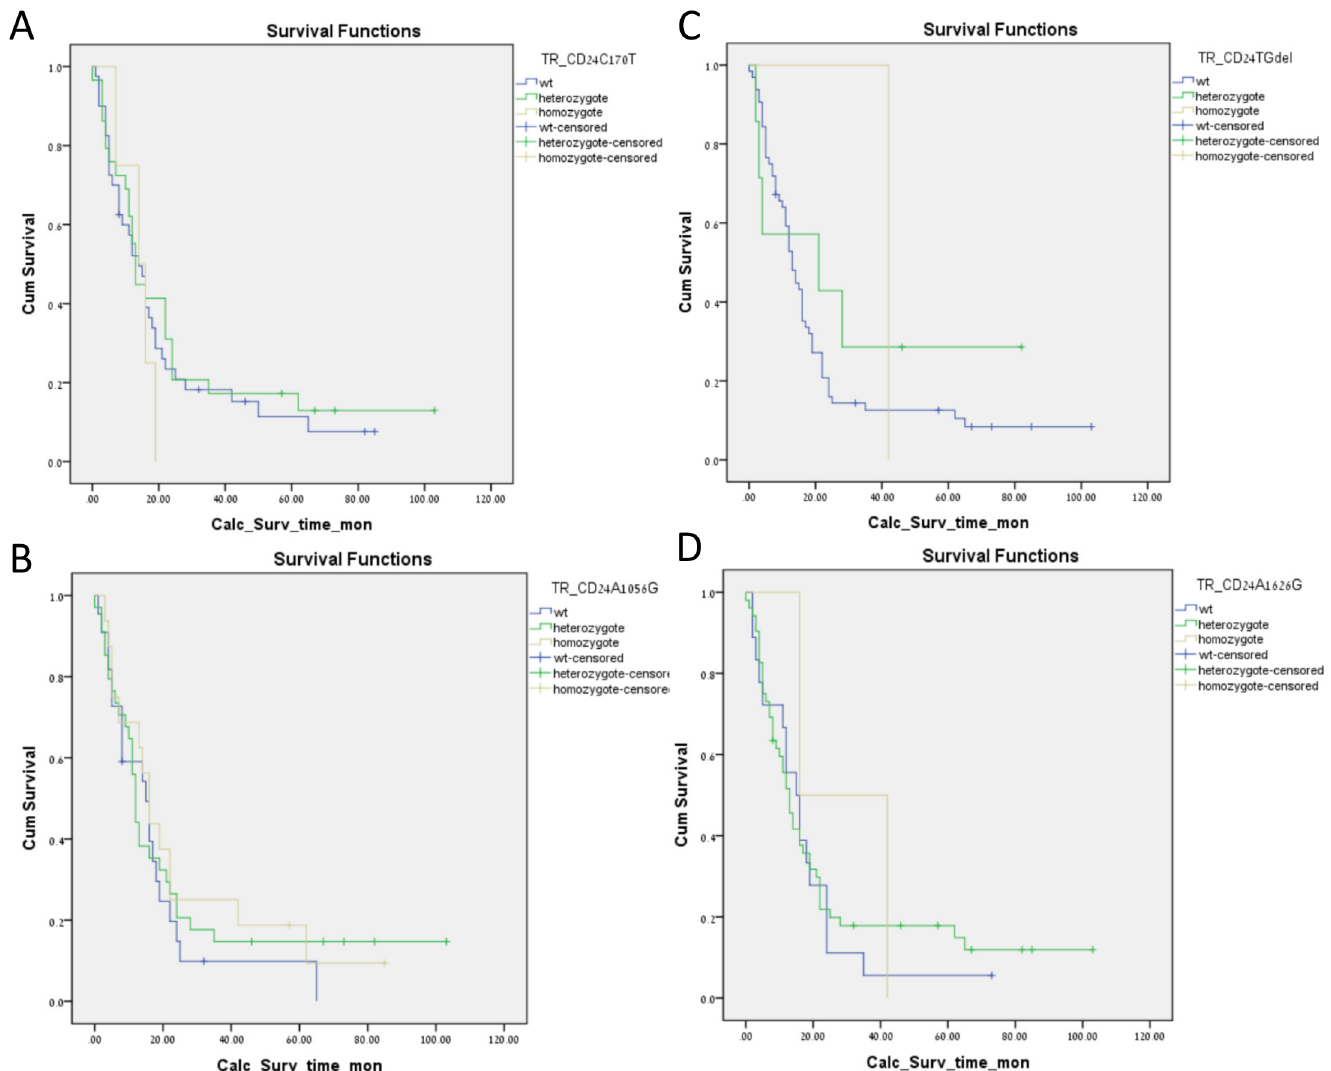
Fig 2. Kaplan-Meir survival curves. A. For CD24 170 C ! T polymorphism. B For CD24 1527 tgdel polymorphism. C For CD24 1056 A ! G polymorphism. D For CD24 1626 A ! G